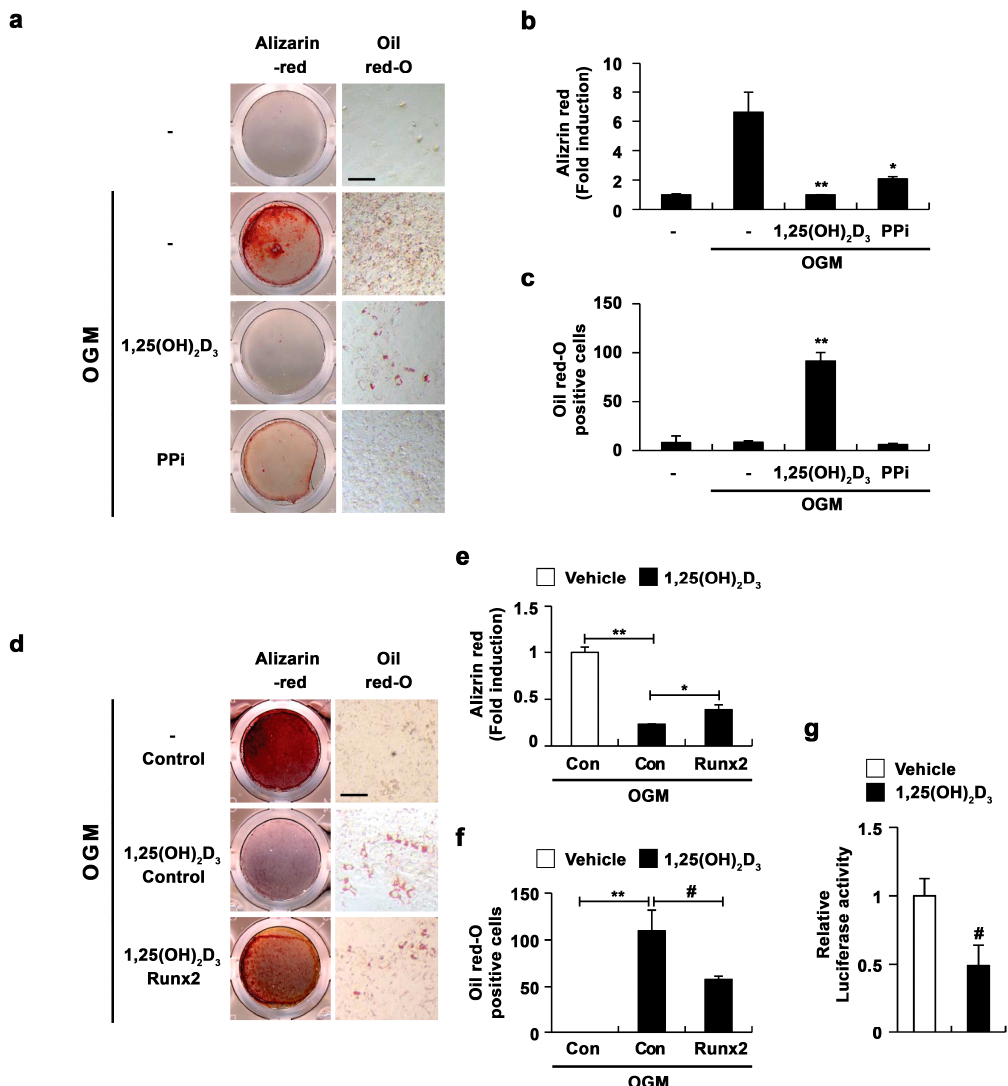
Figure 5. 1,25(OH) 2 D 3 induces transdifferentiation of osteoblasts to adipocytes by inhibiting Runx2 expression. ( a – c ) Primary osteoblasts were cultured in osteogenic medium (OGM) with vehicle, 1,25(OH) 2 D 3 , or PPi as indicated. ( a ) Cultured cells were fixed and stained with Alizarin red or Oil Red-O, Bar: 50 µm; ( b ) Alizarin red staining was quantified by densitometry at 562 nm; ( c ) The number of Oil Red-O–positive cells was counted; ( d – f ) Osteoblasts were transduced with pMX-IRES- EGFP (control) or Runx2 retrovirus. Transduced osteoblasts were cultured in osteogenic medium (OGM) with vehicle or 1,25(OH) 2 D 3 . ( d ) Cultured cells were fixed and stained with Alizarin red or Oil Red-O, Bar: 50 µm; ( e ) Alizarin red staining was quantified by densitometry at 562 nm; ( f ) The number of Oil Red-O—positive cells was counted; ( g ) C2C12 cells were transfected with a Runx2 reporter construct. Transfected cells were treated with vehicle or 1,25(OH) 2 D 3 for 48 h. Luciferase activity was measured using a dual-luciferase reporter assay system. The data represent means and SD of triplicate samples. # p < 0.05; * p < 0.01; ** p < 0.001 as compared with controls.